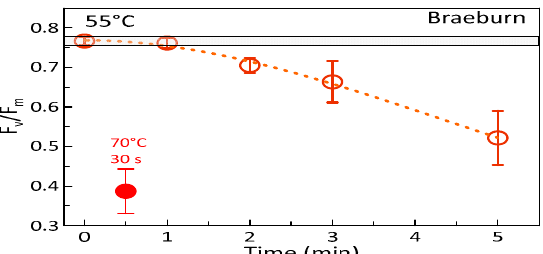
Figure 3. Means of the potential maximum photon yield of PSII (F v / F m ) of ‘Braeburn’ apples ( ± SD; n = 3), hot ‐ water ‐ treated at 55 °C for 0, 60, 120, 180, and 300 s and the effect of hot water treatments at 70 °C for 30 s is also shown. The light ‐ grey horizontal bars indicate the standard deviation of results of the respective controls on day one of the experiment, while the dotted line indicates a polynomial fit.